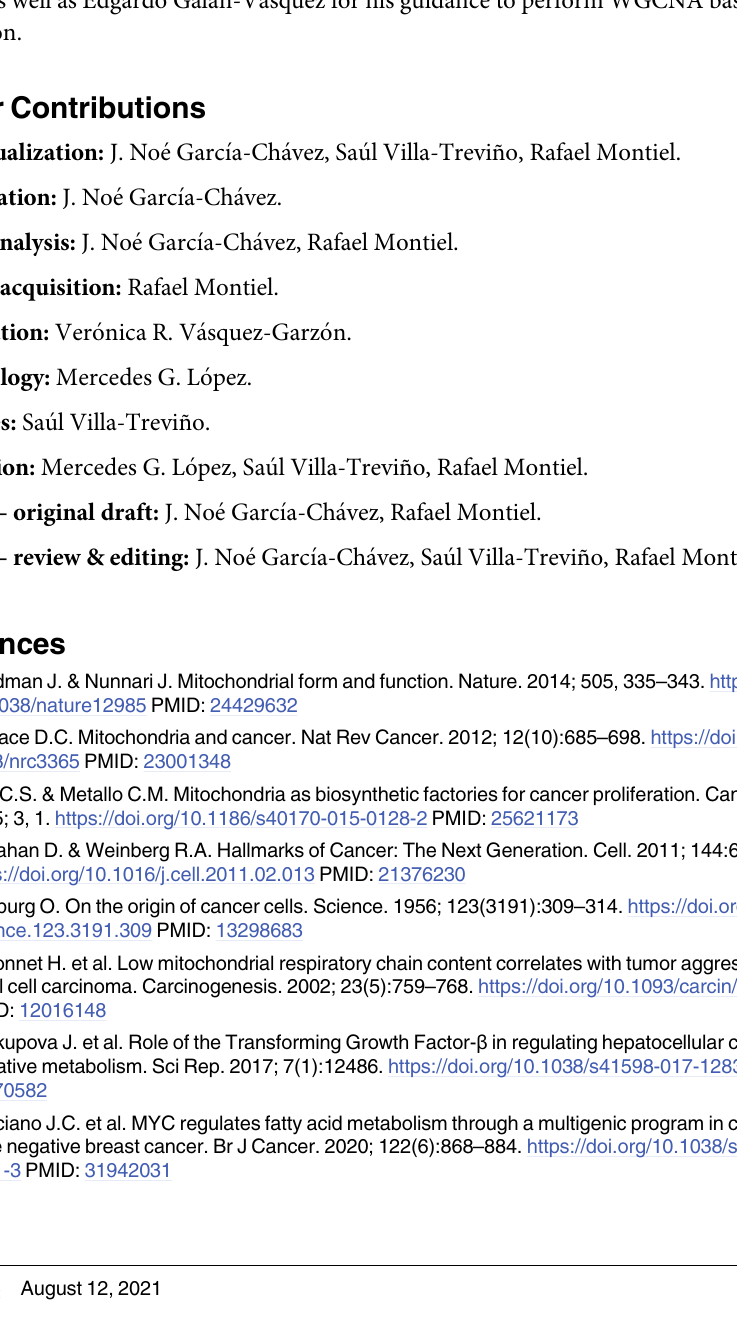
S20 Table. Mitochondrial total protein obtained from each evaluated condition. S21 Table. Over-representation status and number code used in PIB. S22 Table. Nature of origin of missing values in mitochondrial proteomic